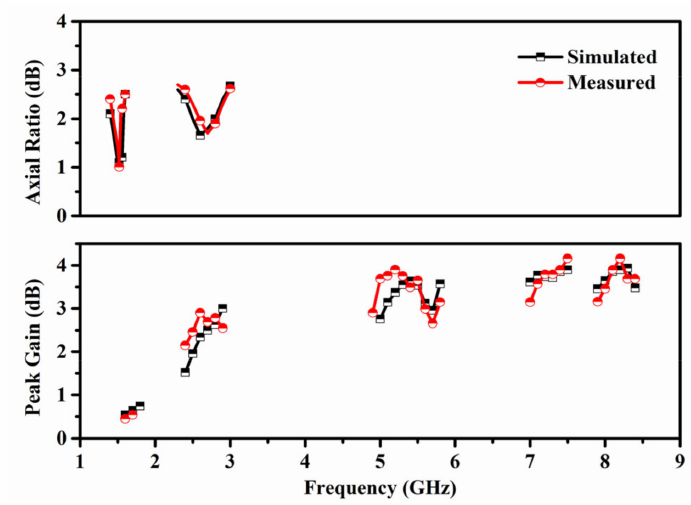
Figure 11. Quad-port antenna simulated axial ratio and gain comparison with measured results.